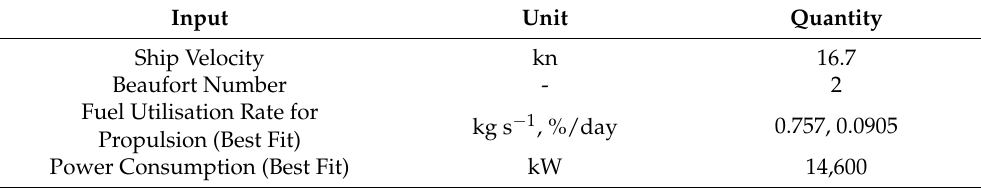
Table 3. Fuel consumption data for the conventional LNG ship at design point [28]. Input Unit